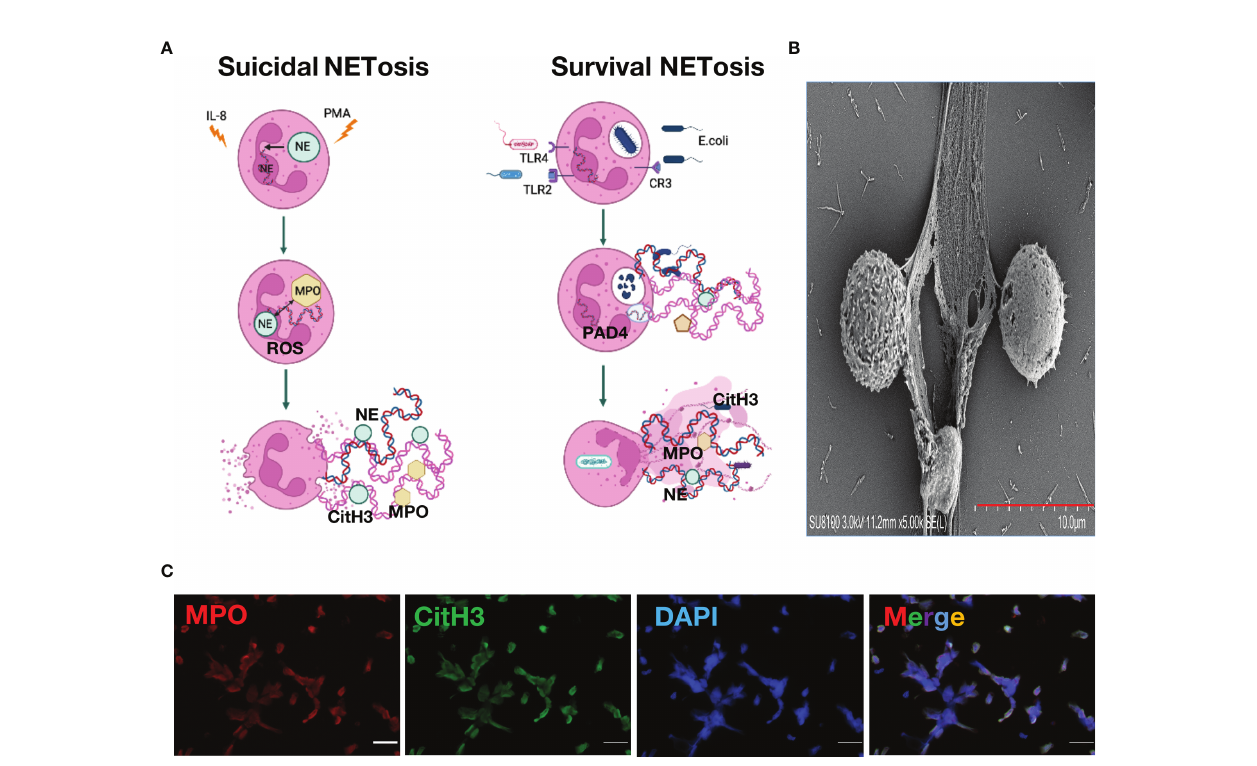
FIGURE 1 | Neutrophil Extracellular Traps. (A) . Mechanism of neutrophil extracellular traps formation (B) . Neutrophil extracellular traps structure under scanning electron microscope (C) . Neutrophil extracellular traps stained with immuno fl uorescence, green, citrullinated histone H3; red, myeloperoxidase; blue,